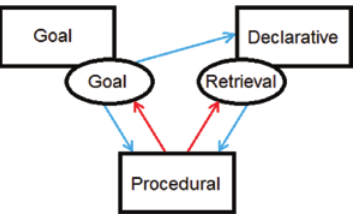
Figure 1: Relationship between Declarative and Procedural Knowledge Memory in the Decision Making Process